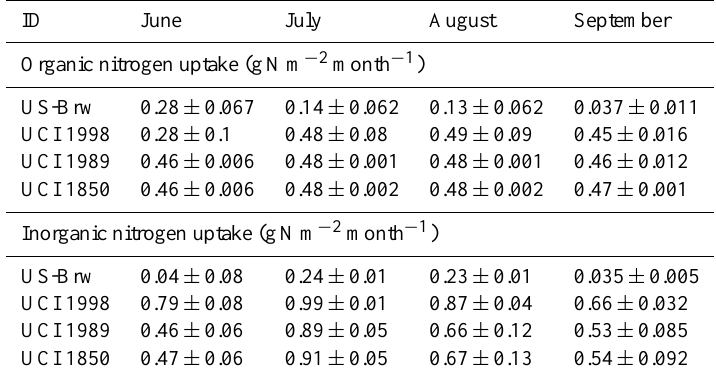
Table 6. The amount of organic nitrogen uptake and inorganic nitrogen uptake by plants during growing season (June–September) at the four sites modeled by